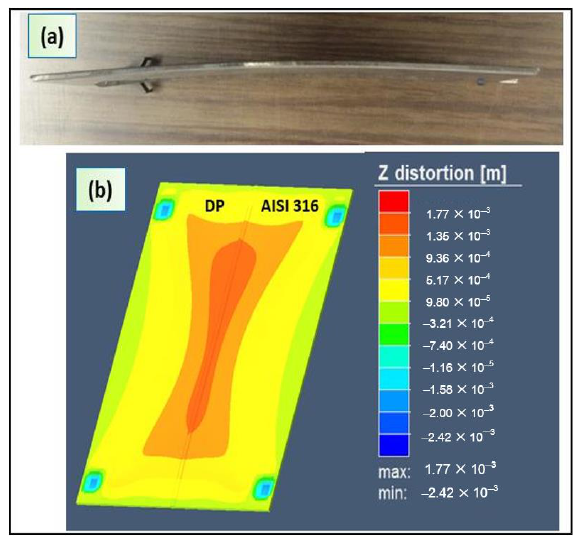
Figure 13. ( a ) Photo show distortion of the plate after welding; ( b ) simulation of welding residual distortion of the DP-AISI plate.